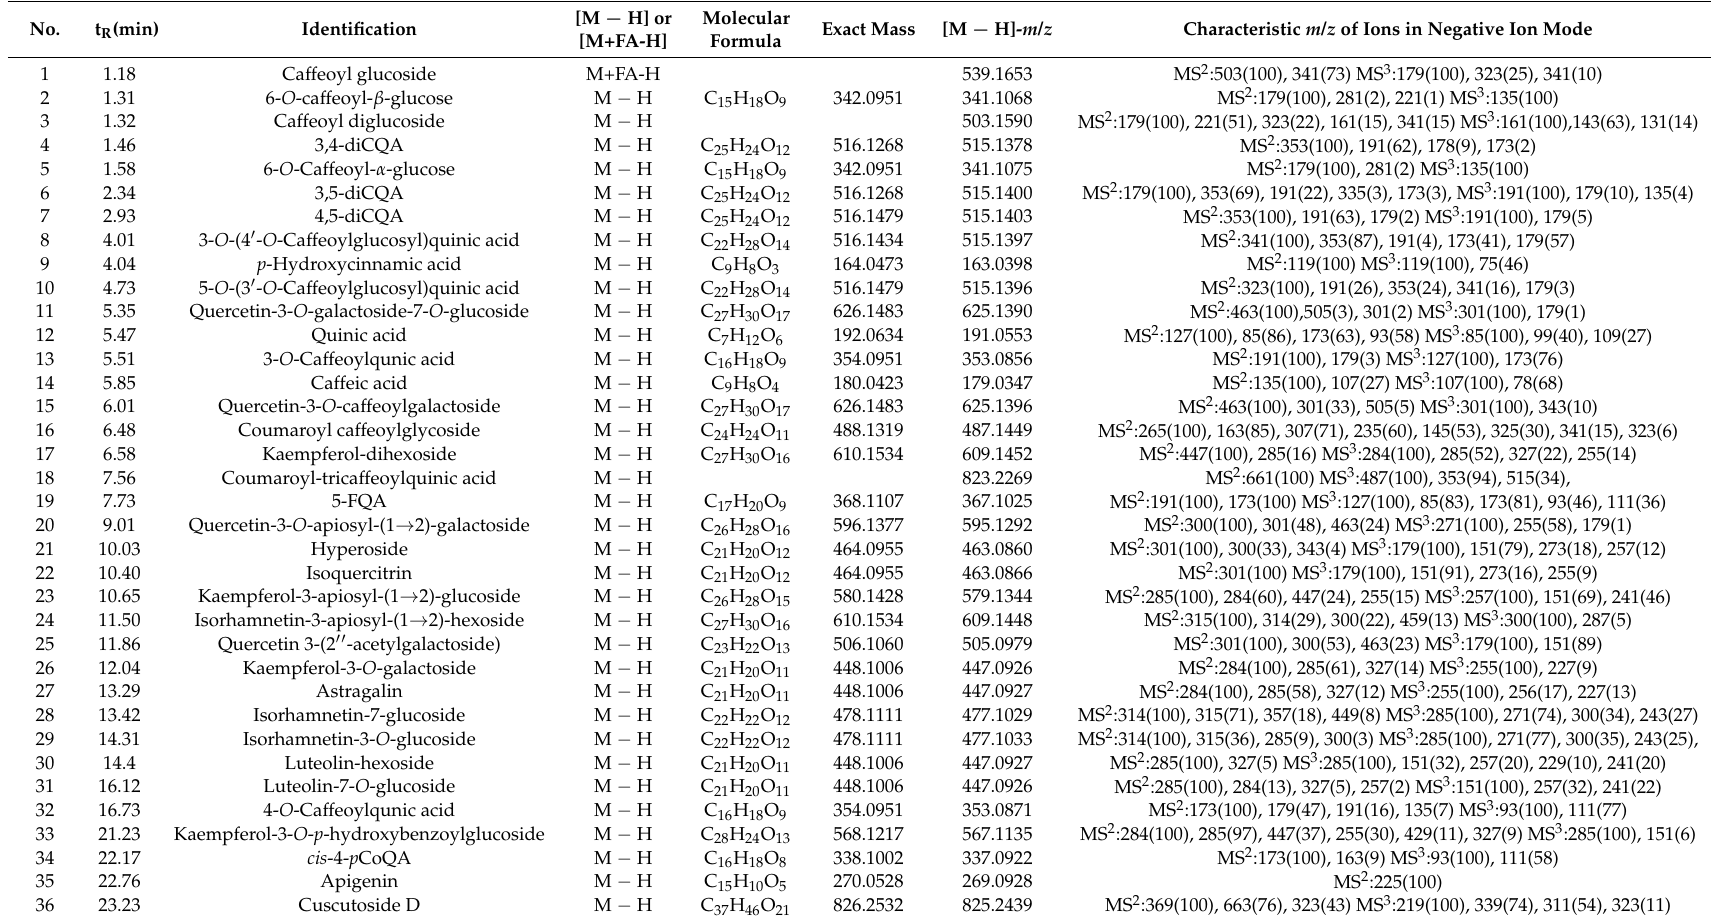
Table 1. Compounds identified in Semen